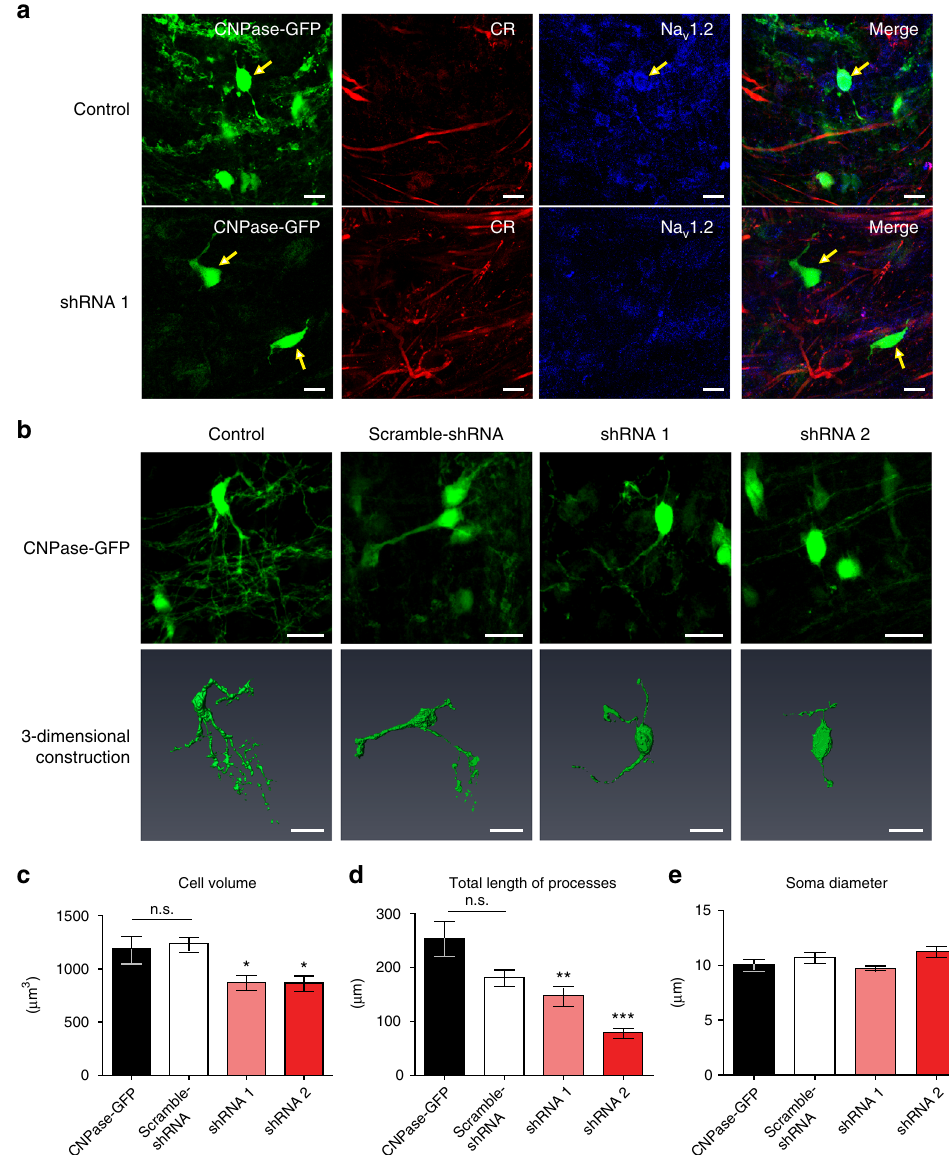
Fig. 8 Na v 1.2 channels are necessary for proper elaboration of pre-OL structures and interaction with axons. a Immunostaining of CNPase-GFP+ cells for calretinin ( red ) and Na v 1.2 ( blue ) in the MNTB (P21) following injection of empty vector (control, upper ) and vector encoding shRNA 1 for Na v 1.2 ( lower ). Yellow arrows indicate shRNA virus-infected cells. Scale bar , 10 μ m b Representative confocal images ( upper ) and 3D reconstruction ( lower ) of CNPase-GFP + pre-OLs in control cells and in cells infected with scrambled shRNA, shRNA1, or shRNA2. Scale bar , 20 μ m. c – e Summary of the data for cell volume c , total length of processes d , and soma diameter e under all conditions. All data represent the mean ± s.e.m.; * P < 0.05, ** P < 0.01, *** P < 0.0001. n.s., nonsigni fi cant